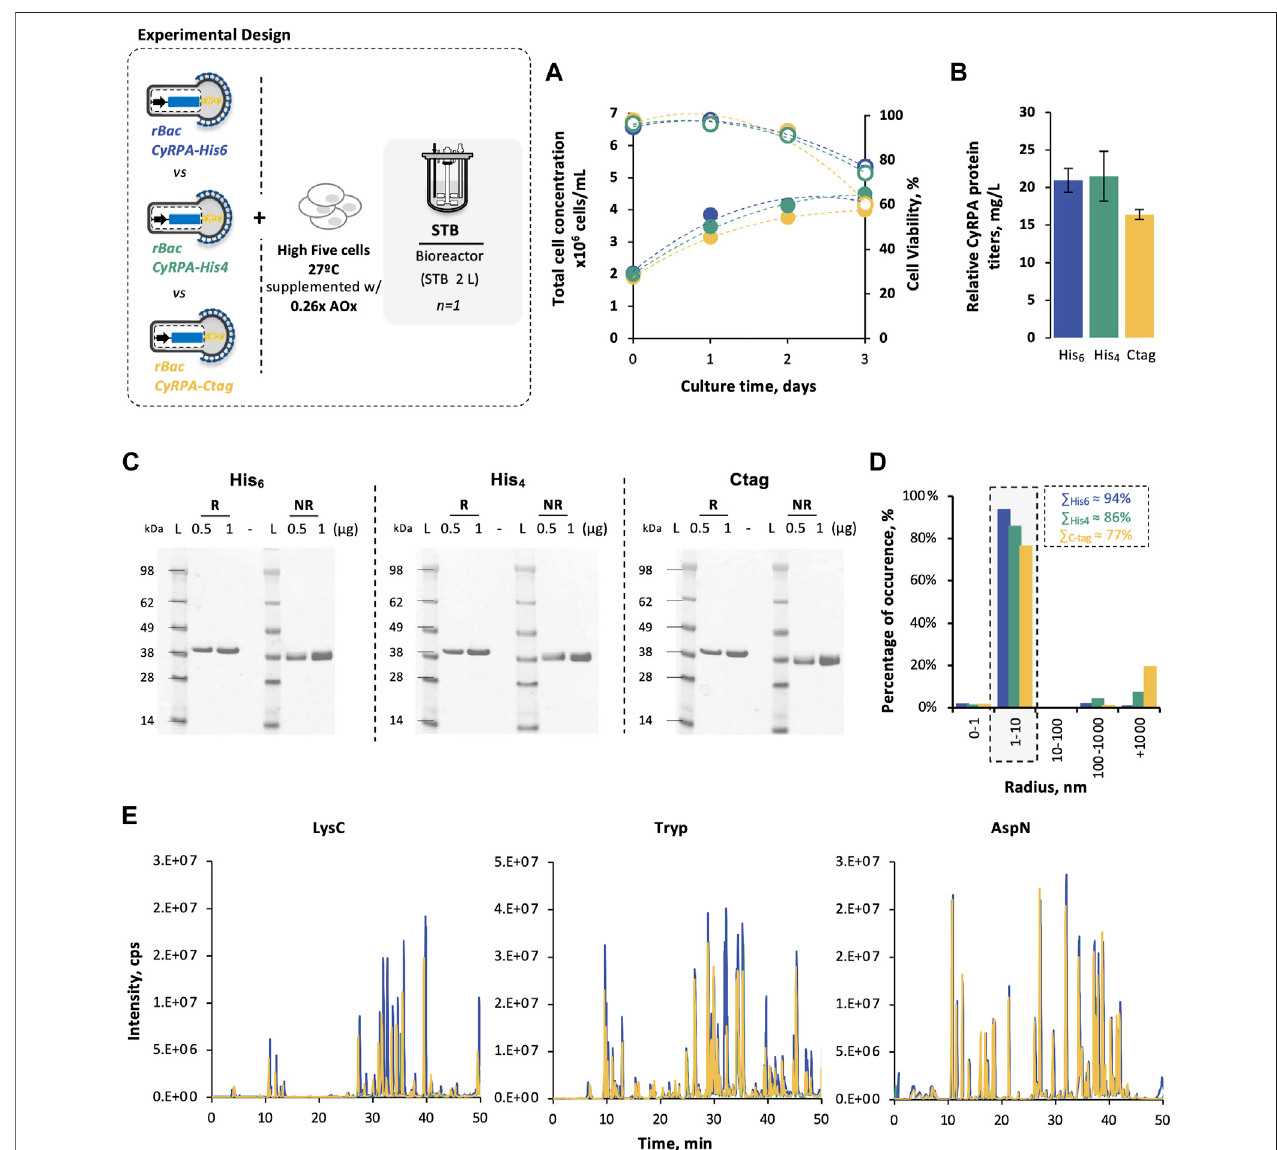
FIGURE 5 | Impact of af fi nity tags on Pf CyRPA production in High Five cells. (A) Cell growth and viability kinetics obtained in STB cultures. (B) Pf CyRPA fi nal yield (mg/L) after puri fi cation. (C) SDS-PAGE of puri fi ed Pf CyRPA, under reduced (R) and non-reduced (NR) conditions; Ladder (L) is SeeBlue ™ Plus2 Pre-stained Protein Standard. (D) Dynamiclightscatteringpro fi leofpuri fi ed Pf CyRPA. (E) Peptideidenti fi cationofpuri fi ed Pf CyRPA,digestedwithLysC,trypsin,andAspN,byLC-MSusing X500B QTOF (ABSciex). Color code: Pf CyRPA-His6 (blue); Pf CyRPA-His4 (green); Pf CyRPA-Ctag (yellow). Data in bar graphs are expressed as mean ± standard deviation (relative to three technical replicates, n = 3). Abbreviations: AOx, antioxidant.